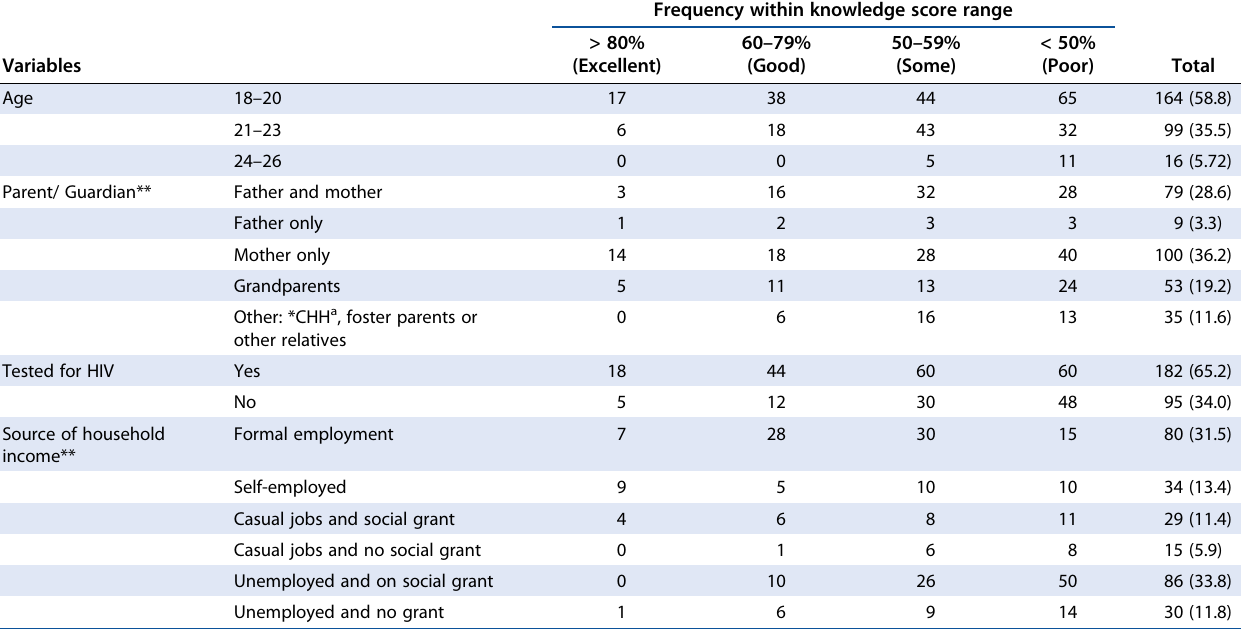
Table 1: Participants ’ reproductive health knowledge scores in relation to demographic